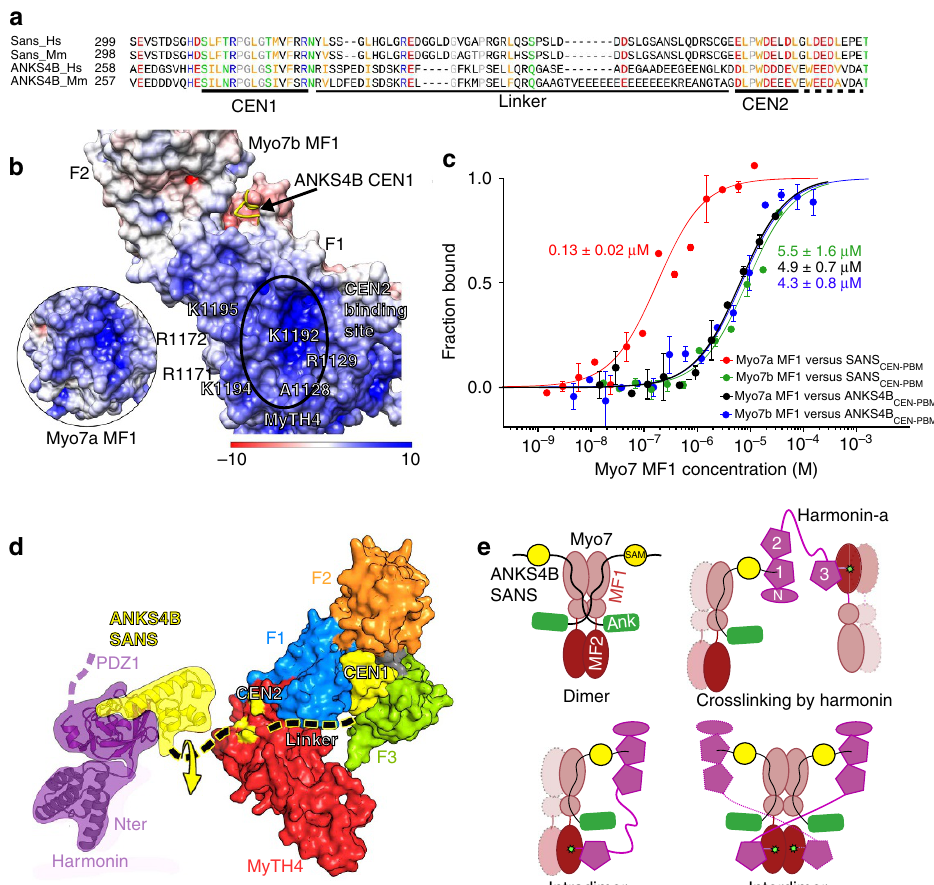
Figure 3 | Myosin 7 MF1 binding to SANS CEN-PBM and ANKS4B CEN-PBM . ( a ) Alignment of SANS and ANKS4B CEN domain (Hs: human; Mm: mouse). Conserved residues are shown in red (negatively charged), blue (positively charged), yellow (hydrophobic), green (polar and not charged) and grey (proline and glycine). ( b ) Electrostatic surface potential of Myo7b MF1/ANKS4B (5F3Y) and Myo7a MF1/SANS (3PVL) (inset). The residues found in the positively charged pocket in the MyTH4 domains that participate in SANS or ANKS4B CEN2 binding are indicated (note that the CEN2 region is highly negatively charged, (a)). The surface potential was calculated using the APBS server with default parameters. ( c ) MSTcurves comparing the Myo7 MF1.SH3 binding to either SANS CEN-PBM or ANKS4B CEN-PBM . Averaged K d s from two technical replicates (mean ± s.d.) are shown. ( d ) Model of the tripartite Myo7 MF1-SANS/ANKS4B-Harmonin complex. The Myo7 MF1 is shown in a surface representation, with the binding site of CEN2 highlighted in yellow. CEN1 and SAM of ANKS4B or SANS are also shown in yellow. The linkers are shown as black dashed line. The short variable linker between CEN2 and SAM domain is likely flexible, allowing for movement of the SAM domain relative to the Myo7 tail (yellow arrow). ( e ). Cartoon models showing the different tripartite complexes that could be assembled. Full length SANS can dimerize via a region between the ANKyrin domain and CEN1 (ref. 35) and, thus, potentially facilitates Myo7 dimerization (dimer). While interacting with MF1 (brown) via SANS/ANKS4B (yellow and green), the long CC1 region of harmonin may allow PDZ3c to reach a MF2 of another Myo7 molecule (crosslinking), the same Myo7 molecule (intradimer), or the other MF2 in the same myosin dimer